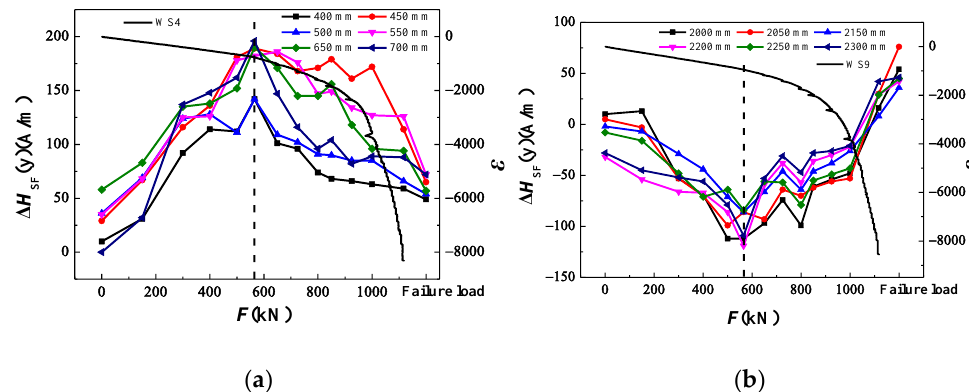
Figure 15. ∆𝐻 SF (y) - F relationship curves of the web: ( a ) left-bending shear section; ( b ) right-bending shear section.